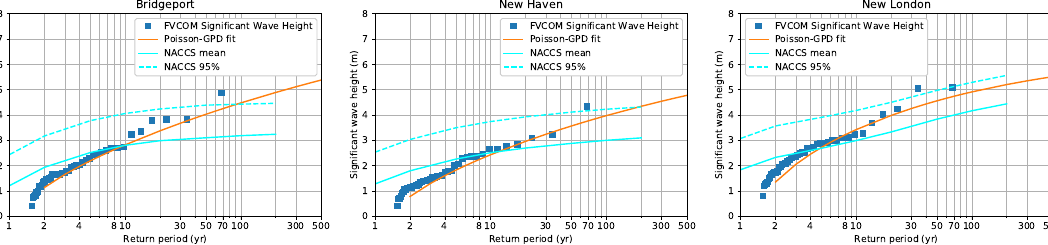
Figure 8. ThesignificantwaveheightandreturnperiodplotsforBridgeport, NewHaven,